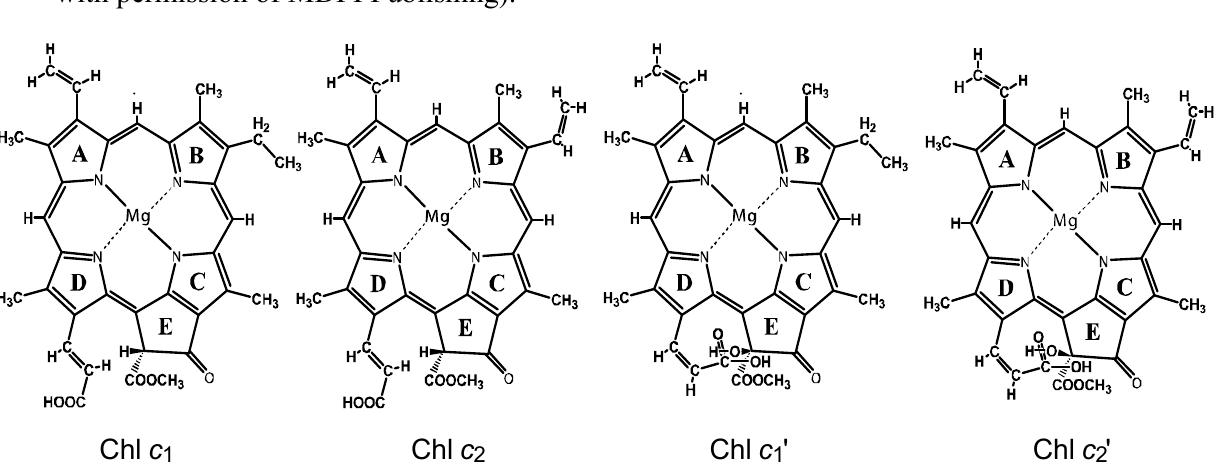
, Chl c , Chl c ’ and Chl c ’ (reprinted from [7] 1 2 1 2